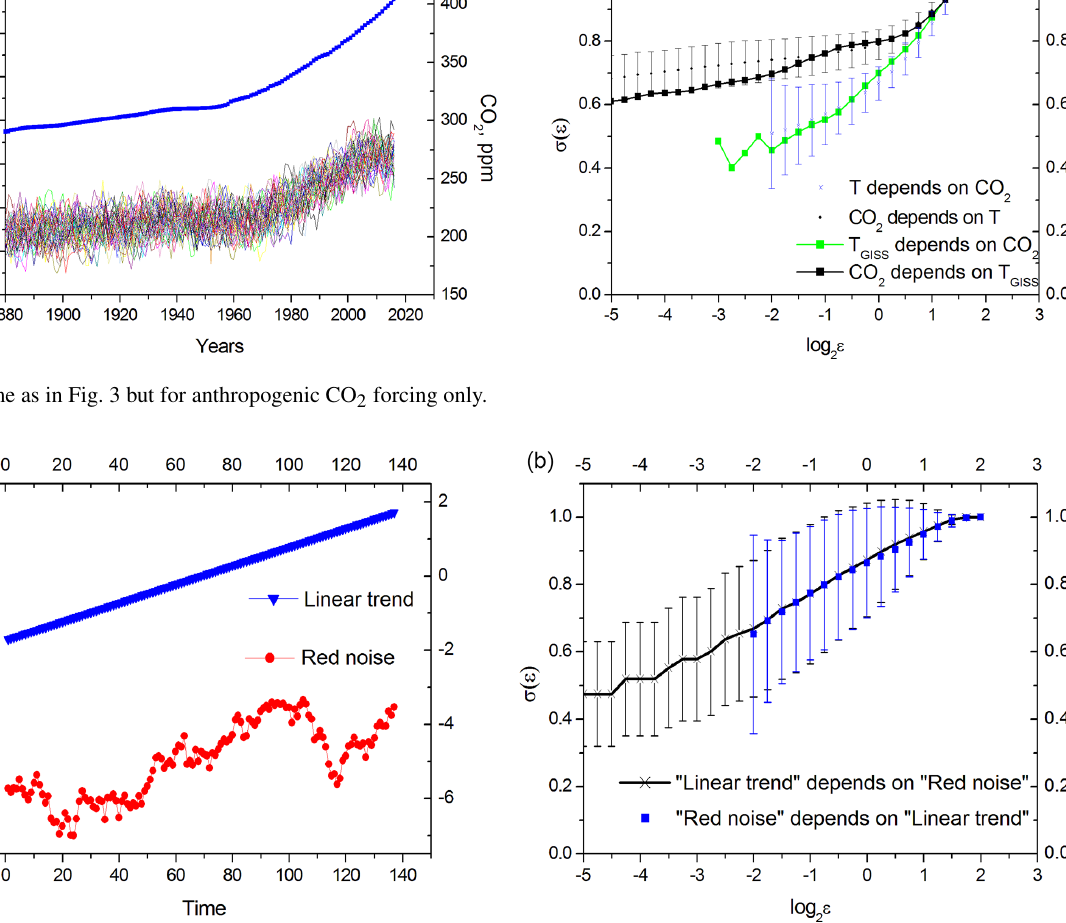
Figure 5. Conditional dispersion of two independent processes having high autocorrelations. (a) Example of one-lag autocorrelated (0.92) red noise series simulating statistical properties of GISS temperature record and a linear trend; (b) average conditional dispersion of 50 red noise surrogates. Error bars mark doubled standard